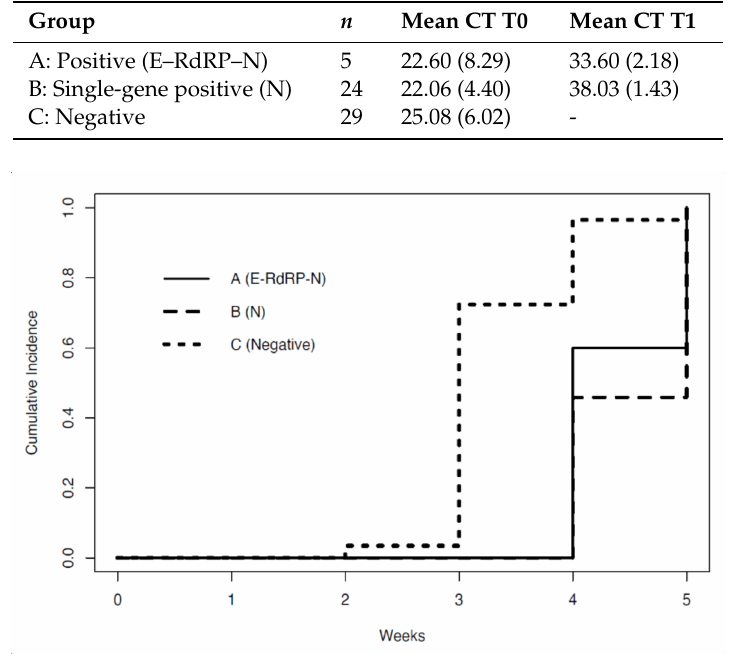
Table 2. Viral loads among three di ff erent groups of HCWs. Data are reported as mean (SD).